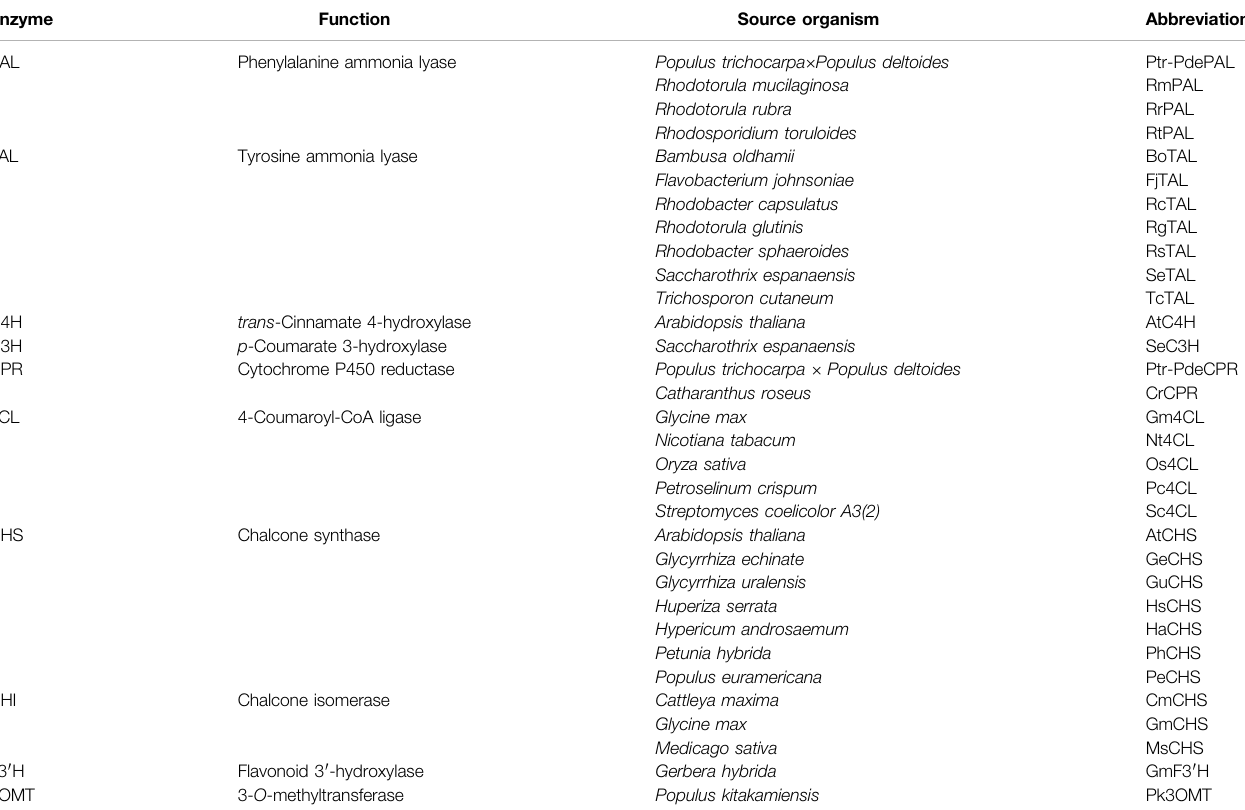
TABLE 4 | Enzyme list for fl avanone biosynthesis. Enzyme